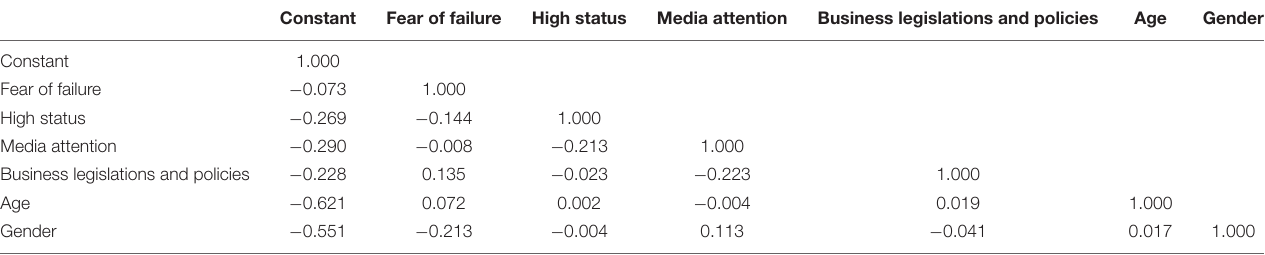
TABLE 4 | Correlation matrix.